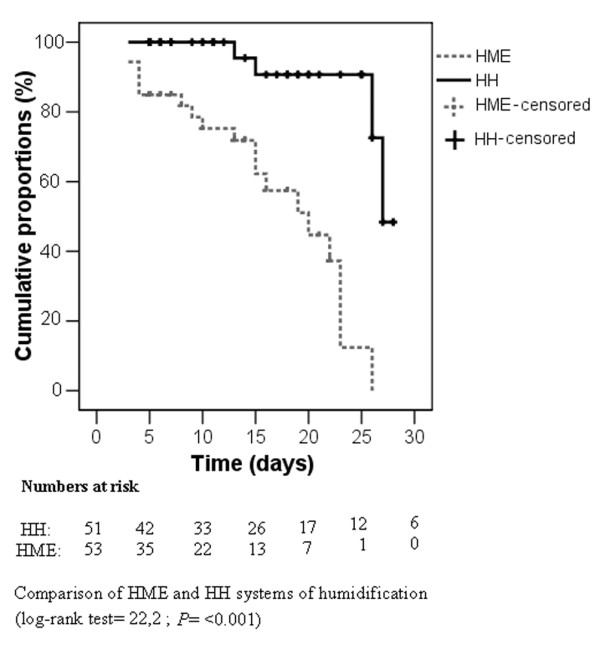
Cumulative proportion of patients remaining free of ventilator-associated pneumonia using heat and moisture exchangers (HMEs) versus heated humidifiers (HHs).